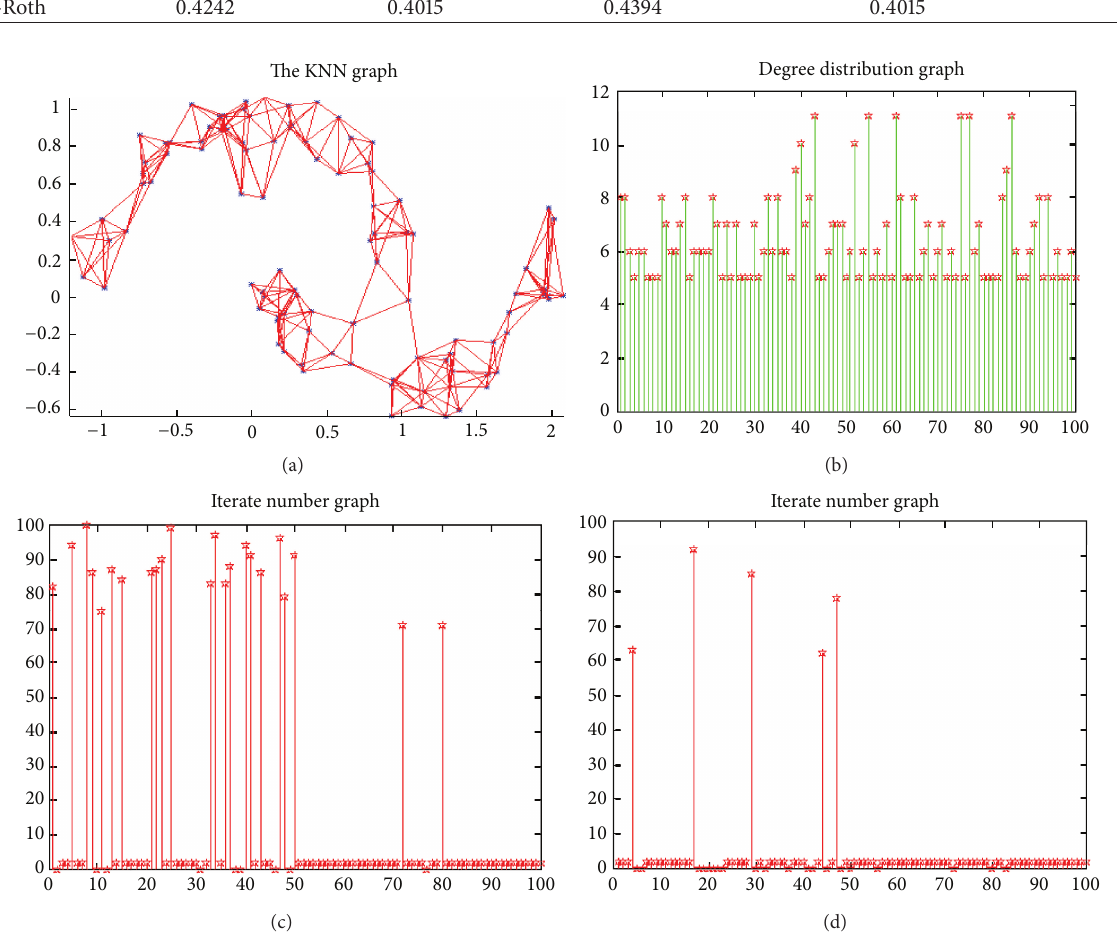
Figure 2: Different pole points of the Wu-Huberman algorithm were applied, which leads to different iterate number of convergence. (a) The KNN (𝑘 = 5) graph. (b) The degree distribution graph. (c) The iterate number via vertical axis when the poles are the 2nd point (its degree is 8) and the 77th point (its degree is 11). (d) The iterate number via vertical axis when the poles are the 5th point (its degree is 6) and the 56th point (its degree is 5), where the 𝑥 -axis represents the data points and 𝑦 -axis represents the iterate